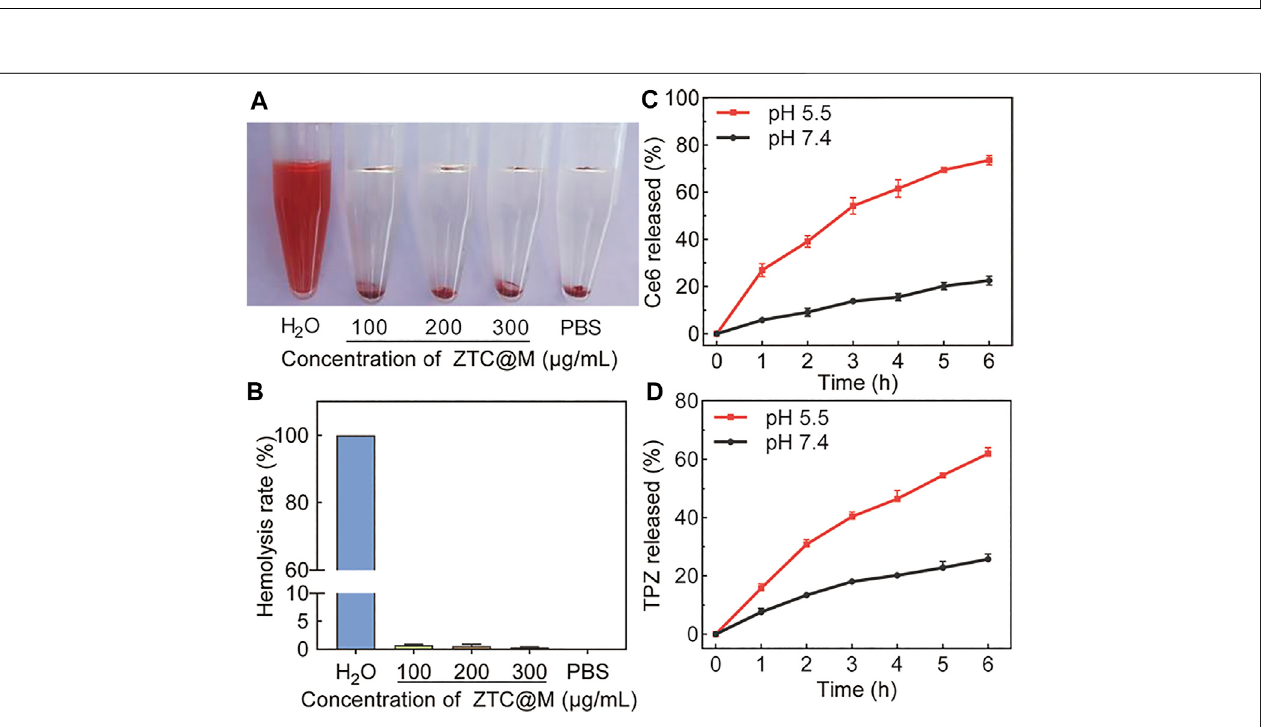
FIGURE3| HemolysisassayofZTC@Matdifferentconcentrations (A) andhemolysisratioofredblood (B) .Ce6 (C) andTPZ (D) controlledreleasecurvesofZTC@ M at different pH.